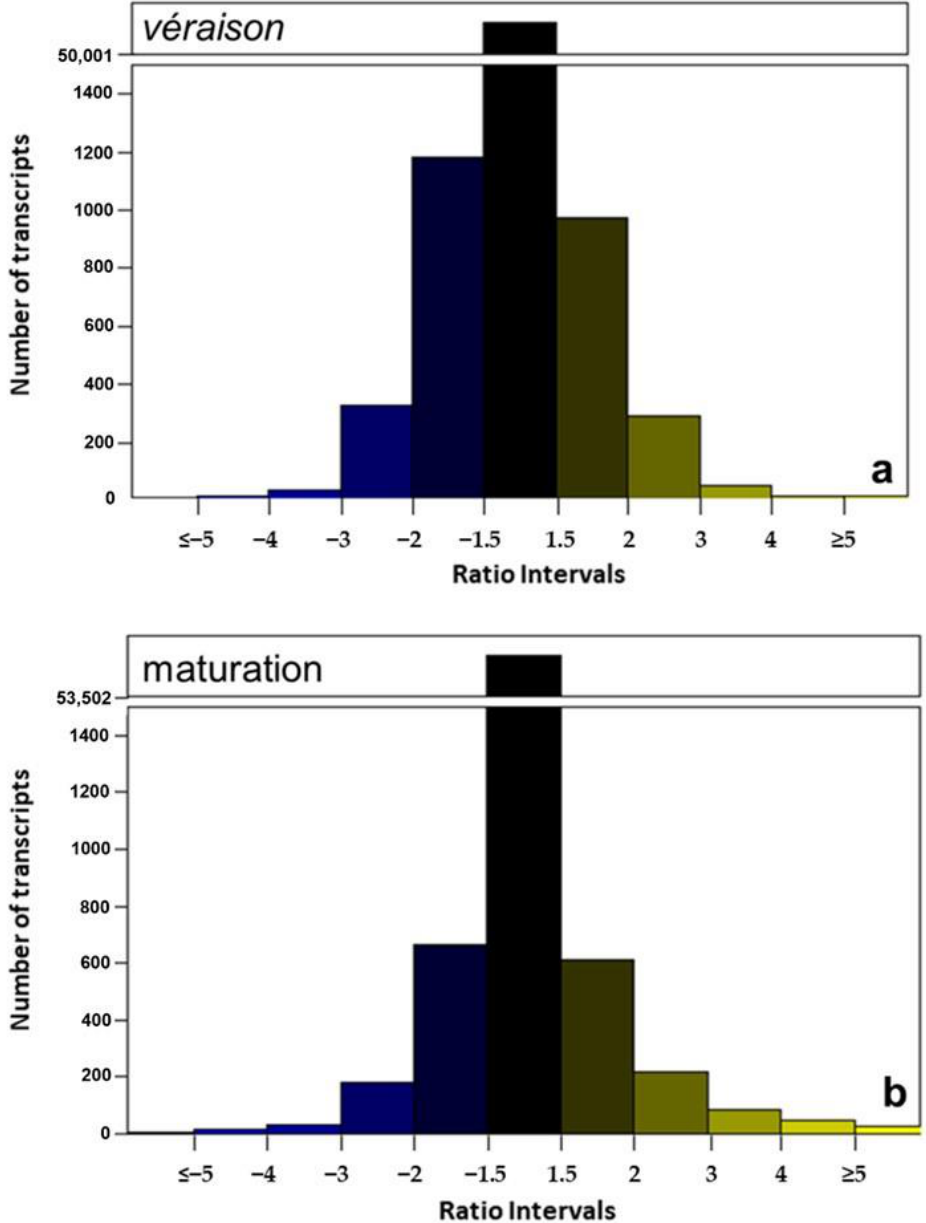
Figure 2. Number of transcripts distribution per ratio interval regulated deficit irrigation/sustained deficit irrigation (RDI/SDI). A scale break was applied from ≈ 1500 to ≈ 50,000 transcripts. ( a ) Véraison samples and ( b ) maturation samples.